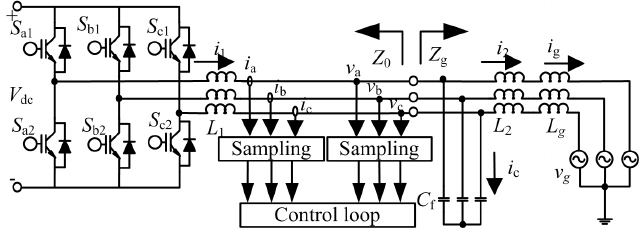
Figure 1. Block diagram of LCL-type inverter with dq -domain GC feedback for grid-connected applications.